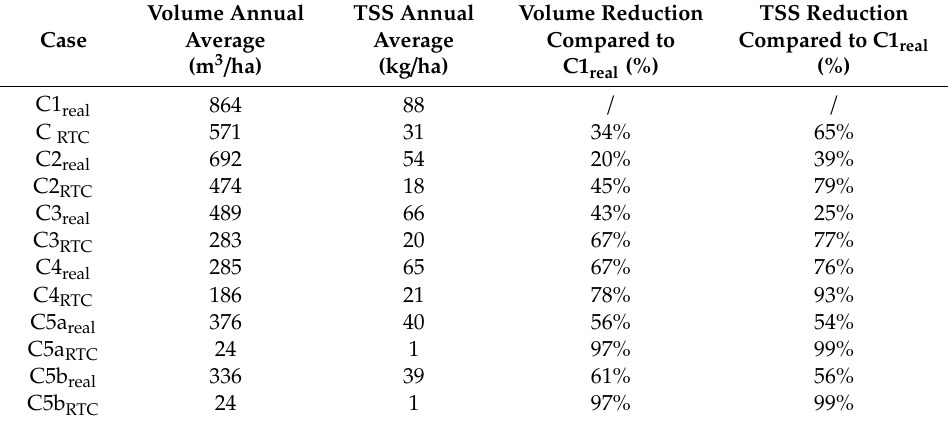
Figure 10. Annual average specific runoff volume ( a ) and annual average specific TSS ( b ) discharged by the CSO. Table 5. Simulation results in terms of specific annual average runoff volume and TSS spilled by the CSO into the receiving water body and relative percentage of reduction using C1 real as the benchmark scenario.